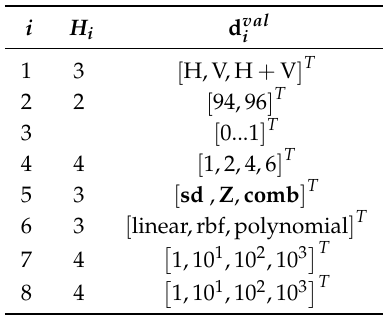
Table 3. Search spaces for adaptive mixed GWO optimizer: parameter index vs. search space